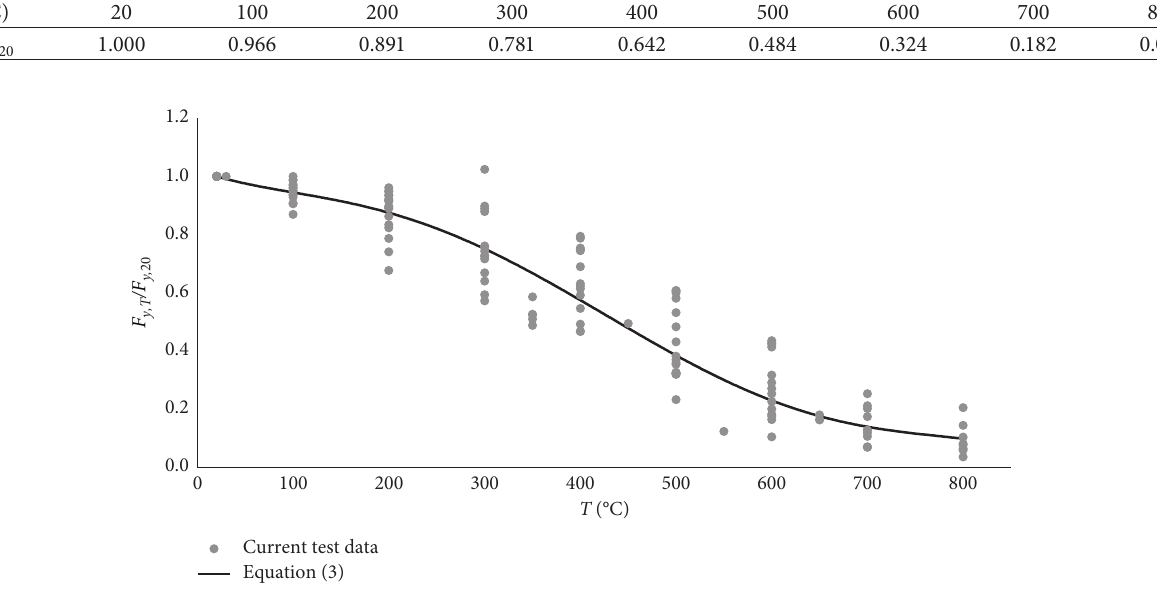
Figure 22: Fitting curve of the retention factors for yield strength of full annealed steels.